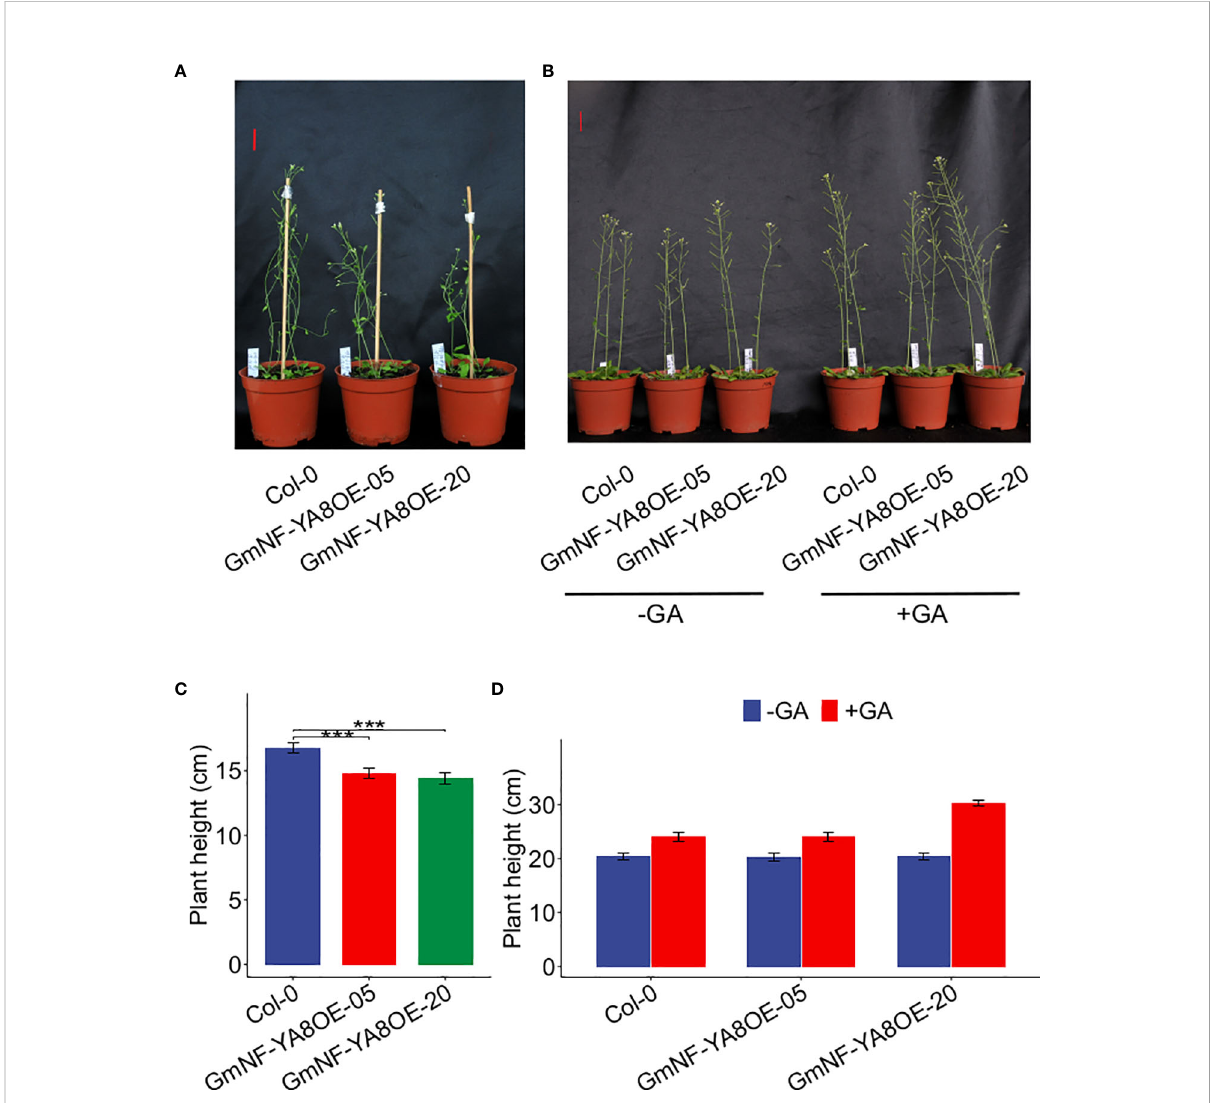
FIGURE 7 Ectopic expression of GmNF-YA8 decreases Arabidopsis plant height The plant height of the non-transformed Col-0 control and transgenic lines GmNF-YA8OE-05 and GmNF- YA8OE-20 was measured on the 25th day after germination (DAG) (A, B) and 35 DAG (C, D) , respectively. Results are means ± SE from each 12 Col-0, GmNF-YA8OE-05, and GmNF-YA8OE-20 plants, respectively. Student ’ s t -test was used to compare the differences between Col-0 and the transgenic lines GmNF-YA8OE-05 and GmNF-YA8OE-20 (*** P < 0.001). Scale bar, 2